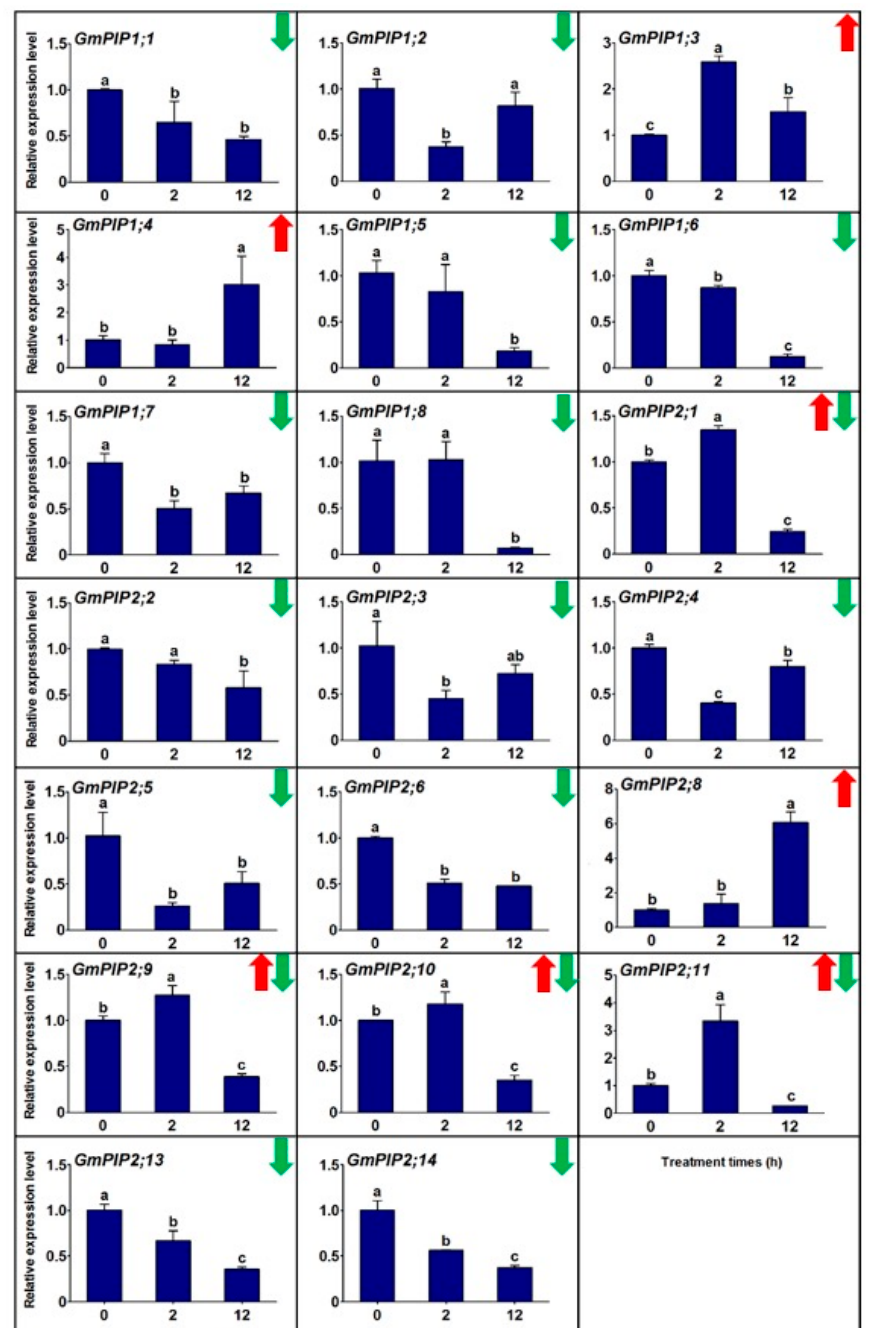
Figure 1. Expression profiles of GmPIPs in response to salt stress. The relative transcript abundances of GmPIP genes in soybean seedling roots were quantified by qPCR, using soybean GmTubulin and GmActin as the internal control. Roots of 2-week-old soybean seedlings were used to investigate the changes in gene expression in response to salt stress (200 mM NaCl for 0, 2, and 12 h). The results are presented as column graphs, with means ± SD of three independent biological replications. Different letters on the bar indicate significant differences ( p < 0.05, one-way ANOVA). The red and green arrow in the left upper corner of the chart mean significant up- and downregulation after salt stress, respectively. Red and green arrows together mean the expression level significantly increased at 2 h but decreased 12 h later.